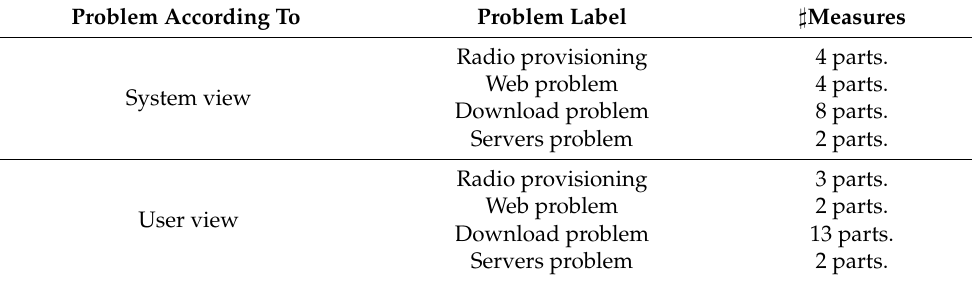
Table 9. Statistics of problem events that occurred compared to geographic